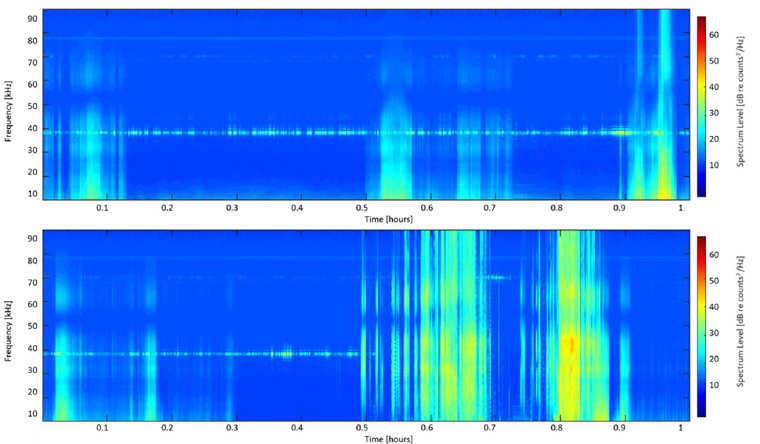
Fig 4. Additional towed-array examples. Long-term spectral average of two different hours of towed-array data, displaying the persistence of a notch in sensitivity at ~ 50 kHz regardless of species present. Panel (a) displays sound data from anthropogenic sources, while (b) displays both anthropogenic noise and a delphinid encounter (starting at ~ 0.5 hours).